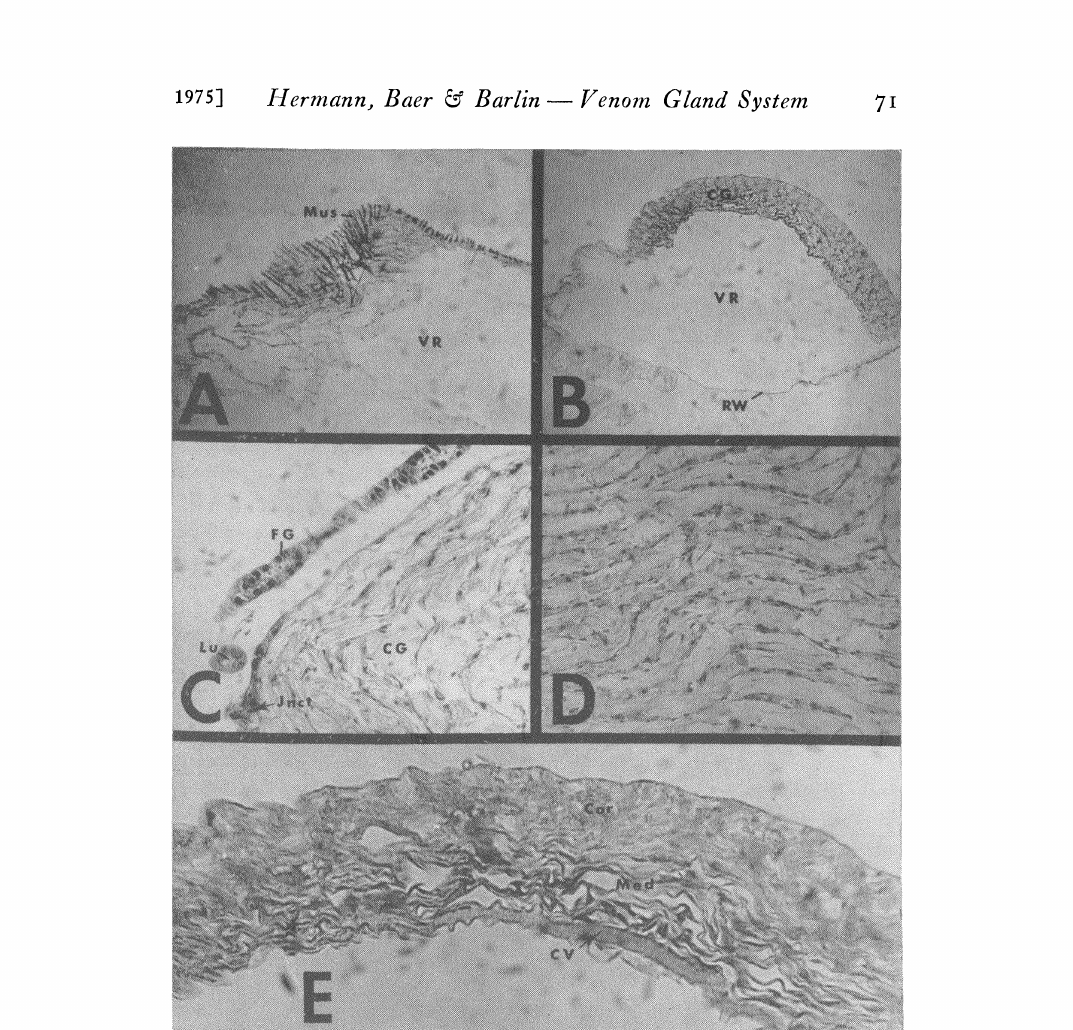
Fig. 2. Sections through the venom components of Camponotus penn- sylvanicus. A--Oblique section, showing periodic transverse muscle in the basal region of the venom sac. B- Transverse section, showing the reser- voir and convoluted gland. C--Horizontal section, showing filament and point of attachmen.t on the convoluted gland. D--Horizontal section through the convoluted gland, showing the arrangement of polygonal cells along collection ducts. E----Transverse section through convoluted gland, showing a well-defined’ cortex and medulla. The large ducts adjacent to the venom reservoir are filled with venom. CG, Convoluted gland. Cor, Cortex of convoluted gland. CV, Collected venom. FG, Filamentous gland. Jnct, Junction between filamentous gland and convoluted gland. Lu, Lumen of filamentous gland. Med, Medulla o convoluted gland. Mus, Muscles transversely arranged around venom sac base. RW, Reservoir wall. VR, Venom